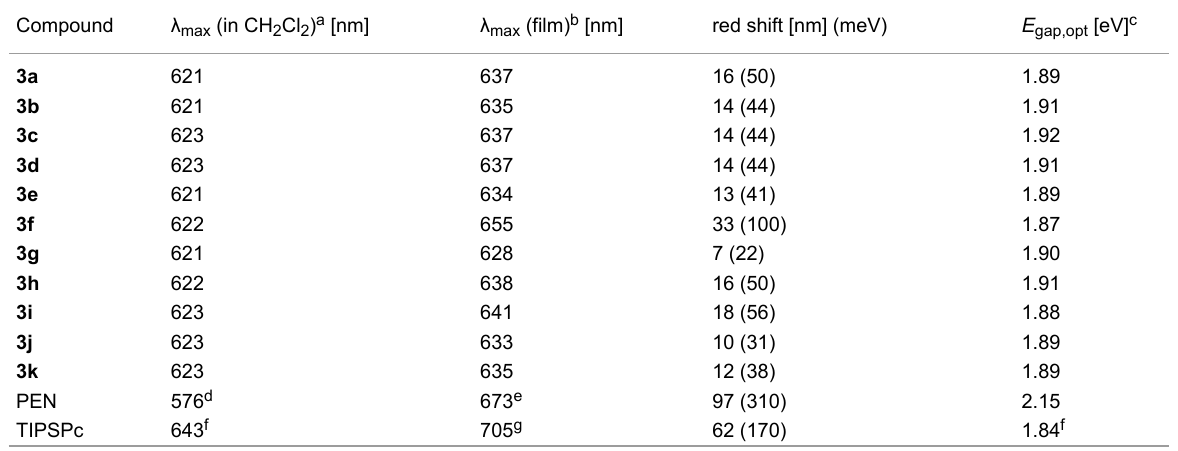
Table 1: Optical properties of pentacenes 3a – k , unsubstituted pentacene (PEN), and TIPSPc. Compound